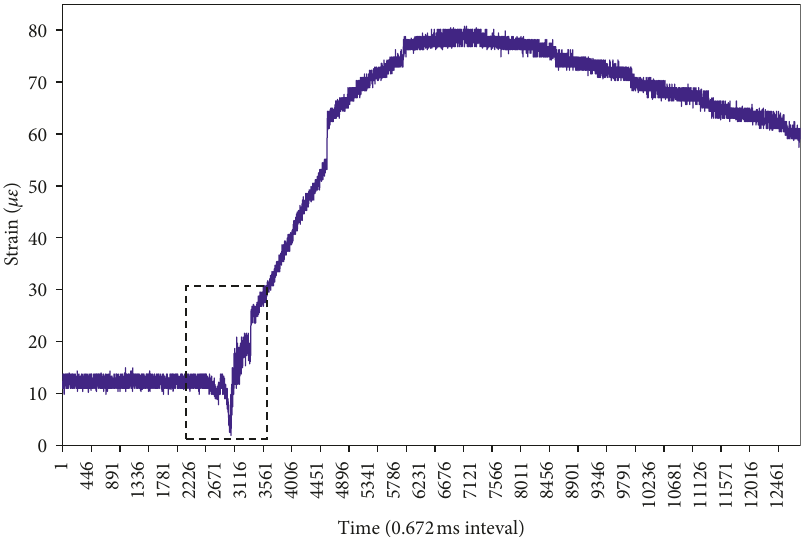
Figure 16: Second test full-term